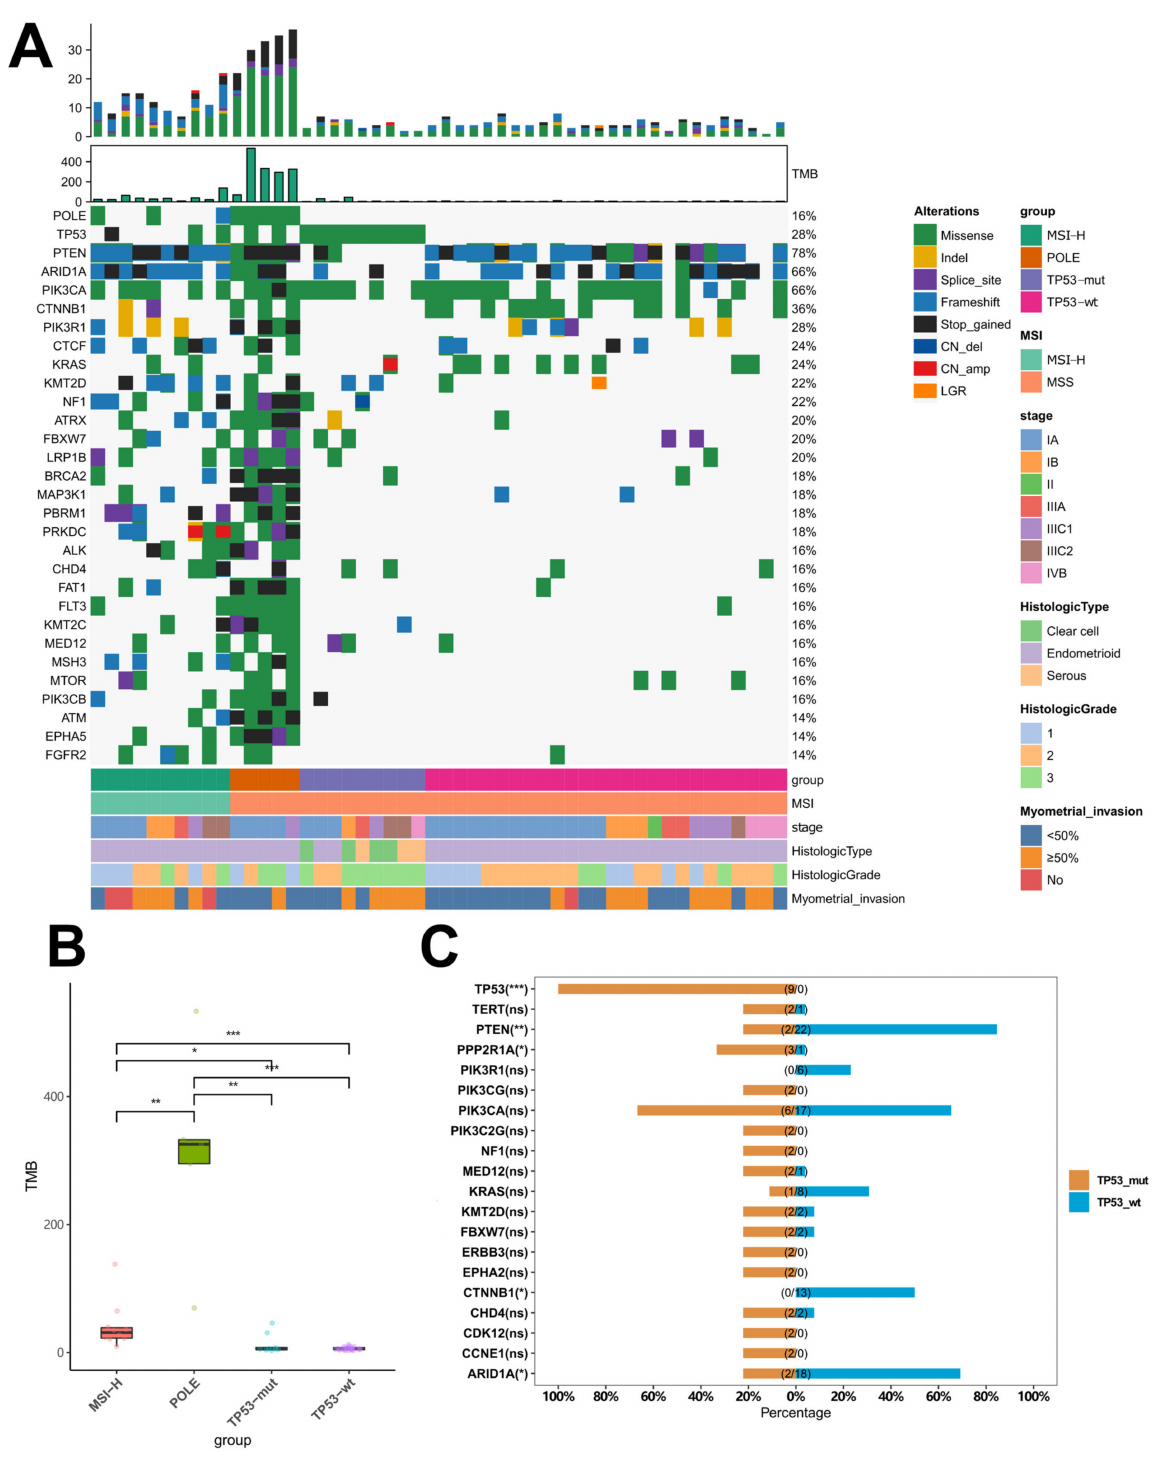
Figure 2. Genomic profiles of patients with different molecular subtypes of endometrial cancer: ( A ) Somatic mutation profile of patients ( n = 50). Different colors on the oncoprint represent the mutation types. Only the genes with a mutation rate of ≥ 10% were included in the oncoprint; ( B ) Comparison of TMB among four different subtypes; ( C ) Comparison of somatic gene mutation rates between TP53 -mutant and wildtype subtypes. Asterisks denote statistical significance; p < 0.05 (*); p < 0.01 (**); p < 0.005 (***); ns: not statistically